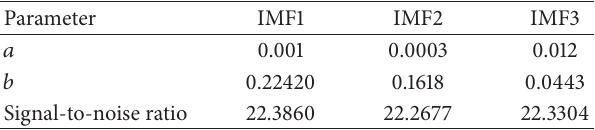
Table 4: The optimal parameter combination of adaptive stochastic resonance of IMF1 ∼